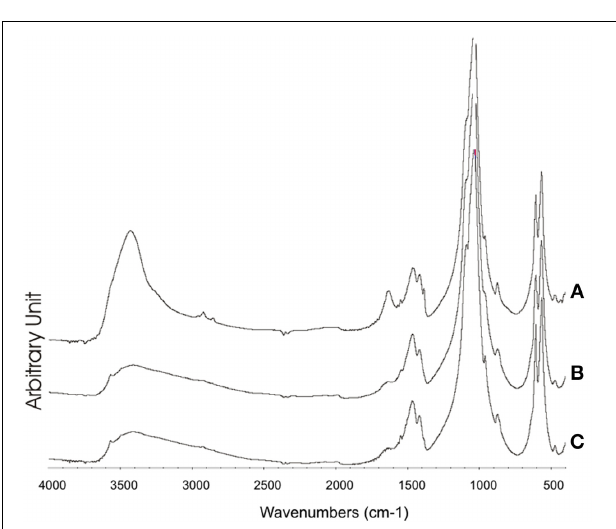
FIGURE 8 | FT-IR of the enamel surface after treatment using. (A) Zn-CHA containing toothpaste, (B) KNO 3 /NaF toothpaste, (C) Fluoride